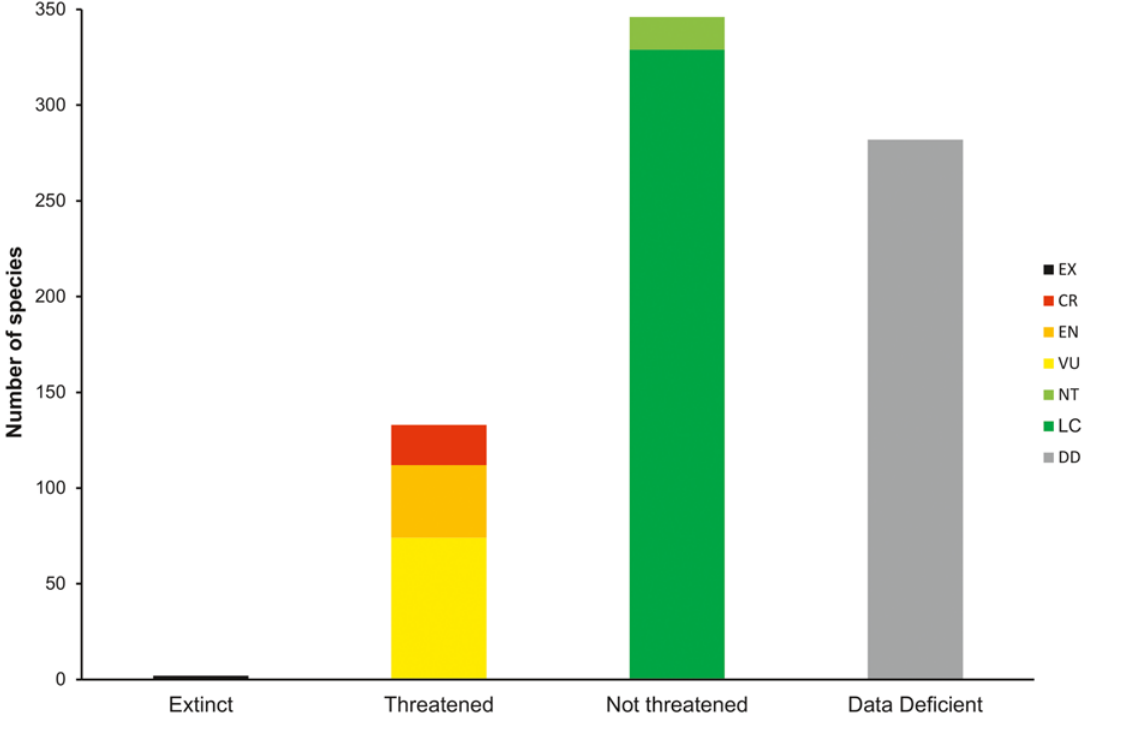
Fig 4. Global extinction risk of freshwater shrimps.